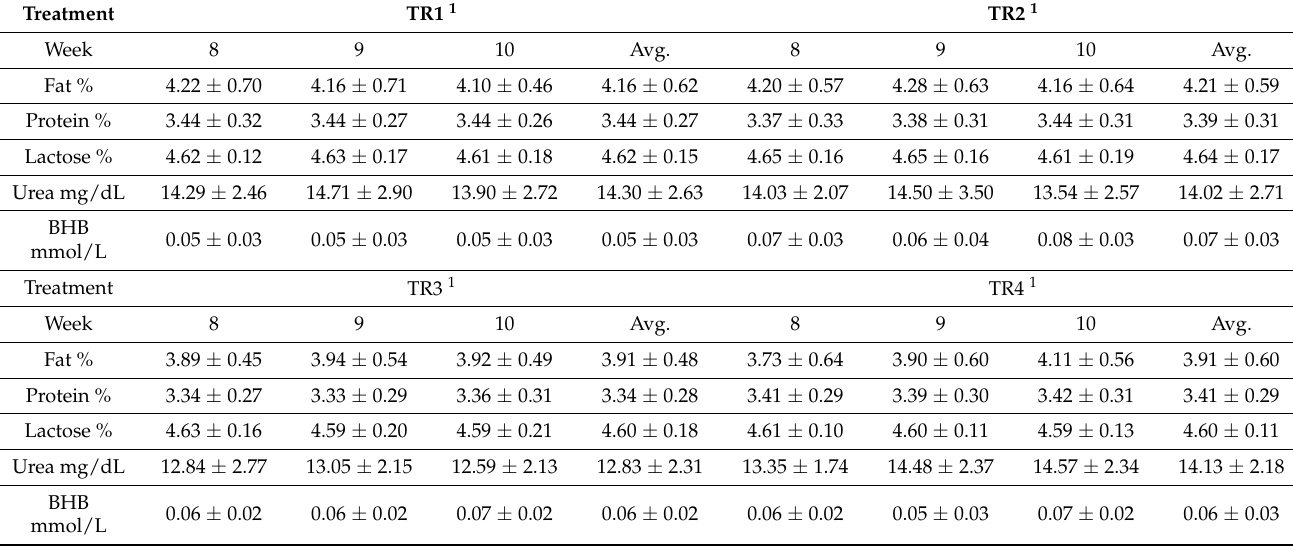
Table 5. Milk composition data ± SD for weeks 8–10 for the tie-rail trial with long-term averages by treatment. Treatment TR1